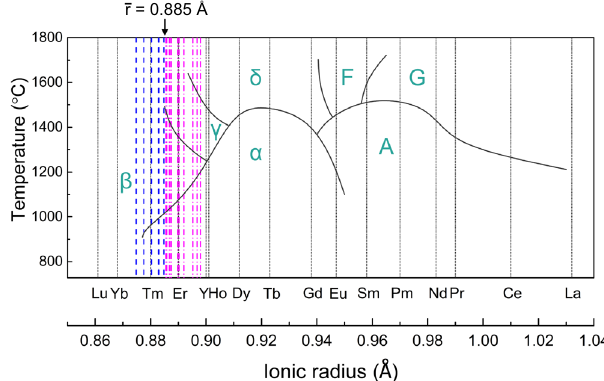
Fig. 7 | The polymorphic formation and transformation diagram for RE 2 Si 2 O 7 materials.Thecyanletters( α , β , γ , δ ,A,F,andG)representthesevendifferent polymorphs of single-RE-principal-component RE 2 Si 2 O 7 materials. The results forthe(RE I 0.25 RE II 0.25 RE III 0.25 RE IV 0.25 )Si 2 O 7 compositionssynthesizedinthisworkare added for comparison. The blue dash lines and the pink dash-dot lines mark the average RE 3+ radius of the compositions that are fi nally stabilized at β and γ poly- morphs, respectively, at high temperatures. The β - γ boundary located at the average RE 3+ radius of (cid:1) r ~0.885Å is marked with arrow for emphasis. The stability range for single-RE-principal-component RE 2 Si 2 O 7 is reproduced based on Ref. 9 , Bondar, I.A., Rare-earth silicates, Ceramics International, 8, 83 – 89, Copyright (1982), with permission from